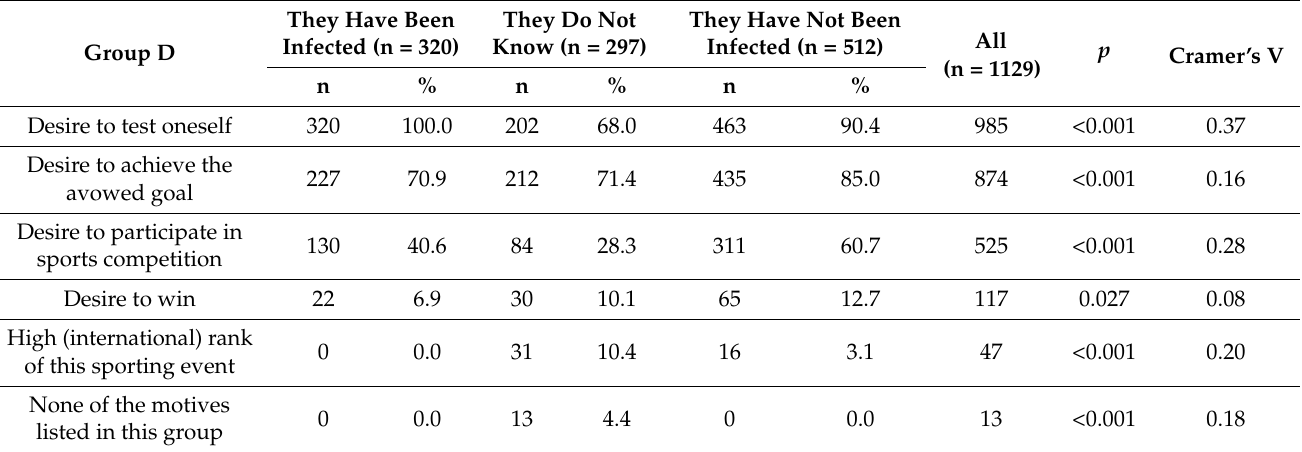
Table 5. Motives within the scope of result orientation versus COVID-19